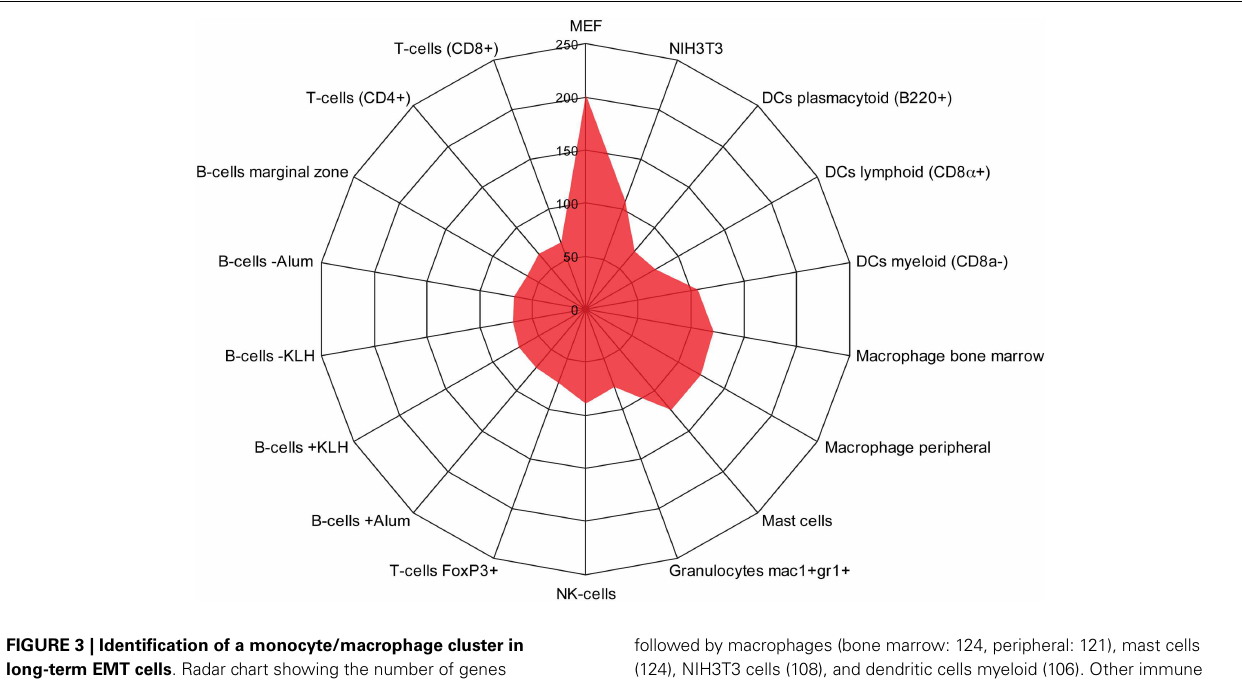
FIGURE 3 | Identification of a monocyte/macrophage cluster in long-term EMT cells . Radar chart showing the number of genes upregulated in long-term EMT cells and enriched in mesenchymal cells [NIH3T3 and mouse embryonic fibroblasts (MEF)] or various types of immune cells.The highest number of genes was found in MEFs (202)